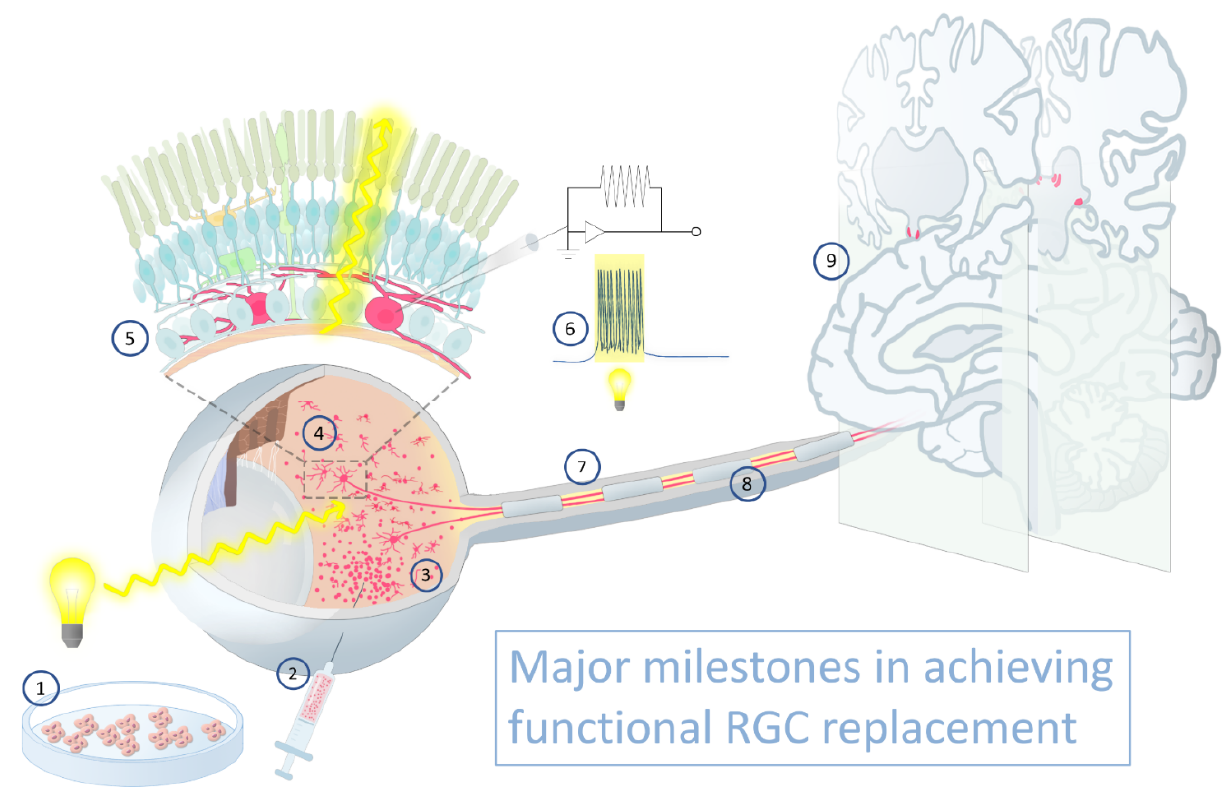
Figure 1. Major milestones in achieving functional RGC replacement: ( 1 ) Develop a reliable source of transplantable RGCs. ( 2 ) Deliver donor cells (depicted in red) safely. ( 3 ) Promote long-term donor RGC survival in the recipient eye. ( 4 ) Establish retinal localization and neuritogenesis. ( 5 ) Form synaptic connectivity with host retinal interneurons in the IPL. ( 6 ) Conduct light-evoked, photoreceptor-transduced, signals within the visual pathway. ( 7 ) Achieve axon growth toward the optic nerve head and into the optic nerve. ( 8 ) Ensure myelination of new axons. ( 9 ) Reinnervate retinorecipient nuclei, including suprachiasmatic nucleus, lateral geniculate nucleus, olivary pretectal nucleus, and superior colliculus.